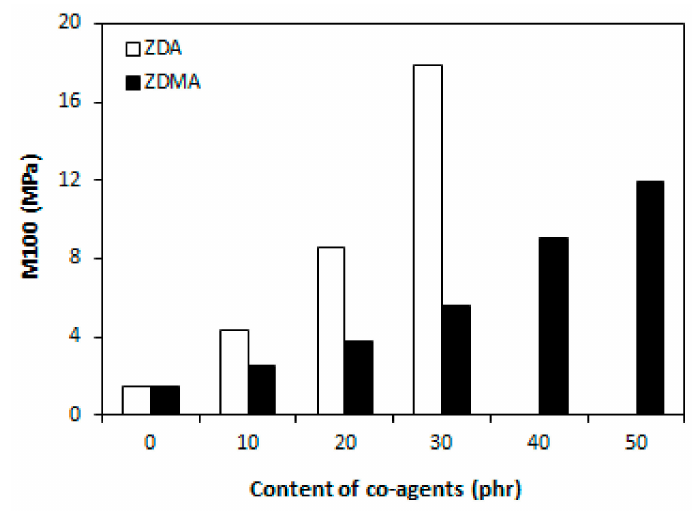
Figure 3. Influence of co-agents content on modulus M100 of composites.